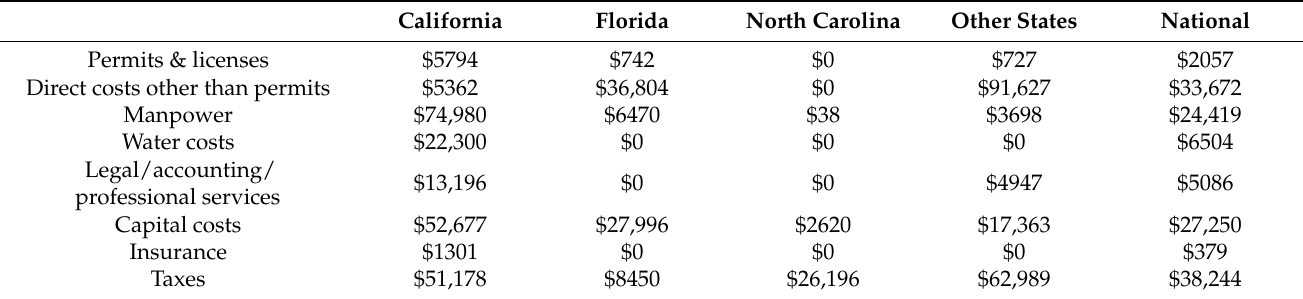
Table 8. Total regulatory costs (by type of cost) by farm and by state (Values in mean $/farm).